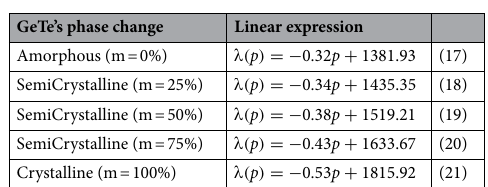
GeTe’s phase change Linear expression Amorphous (m = 0%) (cid:31) ( p ) = − 0.32 p + 1381.93 (17) SemiCrystalline (m = 25%) (cid:31) ( p ) = − 0.34 p + 1435.35 (18) SemiCrystalline (m = 50%) (cid:31) ( p ) = − 0.38 p + 1519.21 (19) SemiCrystalline (m = 75%) Crystalline (m = Table 3. Linearization of the absorber resonant peaks with the periodicity p.